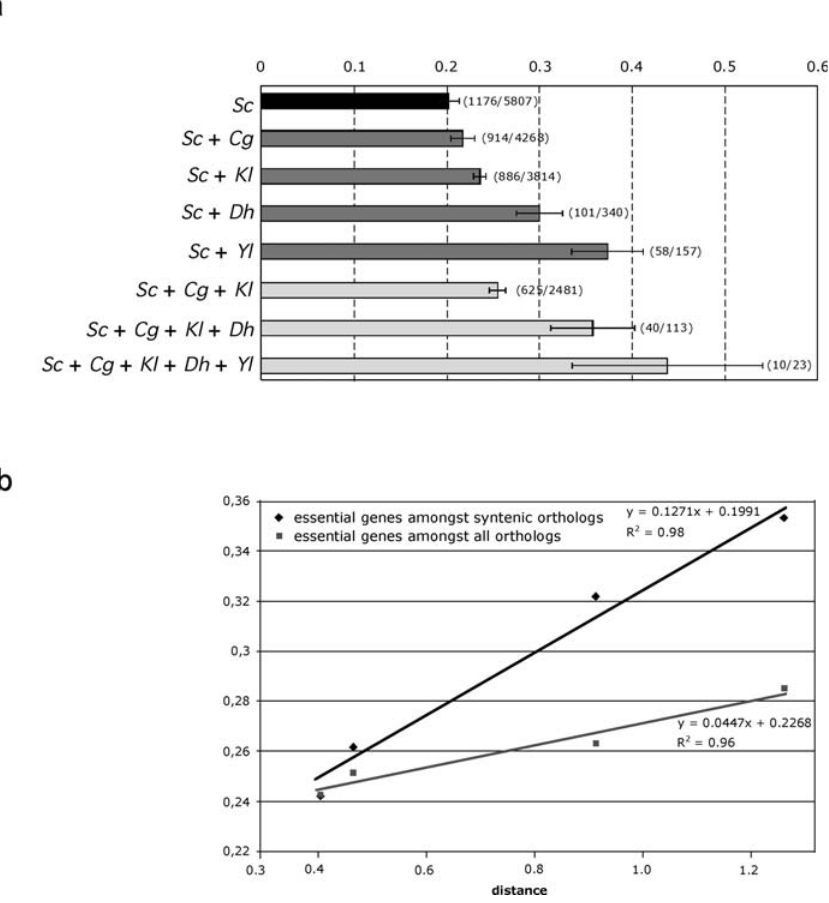
Figure 5. Proportion of Essential Genes within Conserved Synteny Blocks (A) The black bar represents the proportion of essential genes in the genome of S. cerevisiae (Sc), as defined in the Comprehensive Yeast Genome Database (http://mips.gsf.de/genre/proj/yeast). The relative proportions of orthologs to these genes among the total number of genes comprised within the syntenic blocks with the genomes of C. glabrata (Cg), K. lactis (Kl), D. hansenii (Dh), and Y. lipolytica (Yl) are represented by dark gray bars. Proportions of essential genes concomitantly conserved within synteny blocks in three, four, and five species are indicated by light gray bars. Error bars represent two standard deviations, and the number of genes considered in each case is indicated in parentheses. (B) Comparison of the proportions of essential genes among syntenic orthologs and among all orthologs at increasing phylogenetic distances. Phylogenetic distances between S. cerevisiae and C. glabrata, S. cerevisiae and K. lactis, S. cerevisiae and D. hansenii, and S. cerevisiae and Y. lipolytica are reported on the x -axis. DOI: